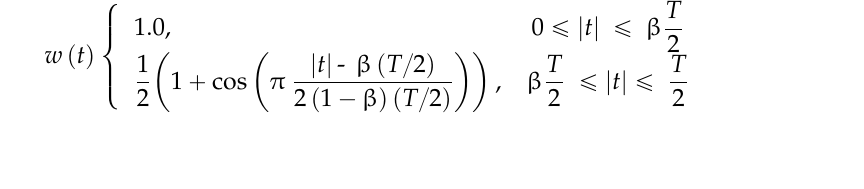
Figure 5. ( a ) Tukey window function; ( b ) chirp with Tukey window; and ( c ) frequency responses. 3.1.2. Gaussian Window In mathematics, a Gaussian function, shown in Figure 6 and often simply referred to as a Gaussian, is a function of the form: